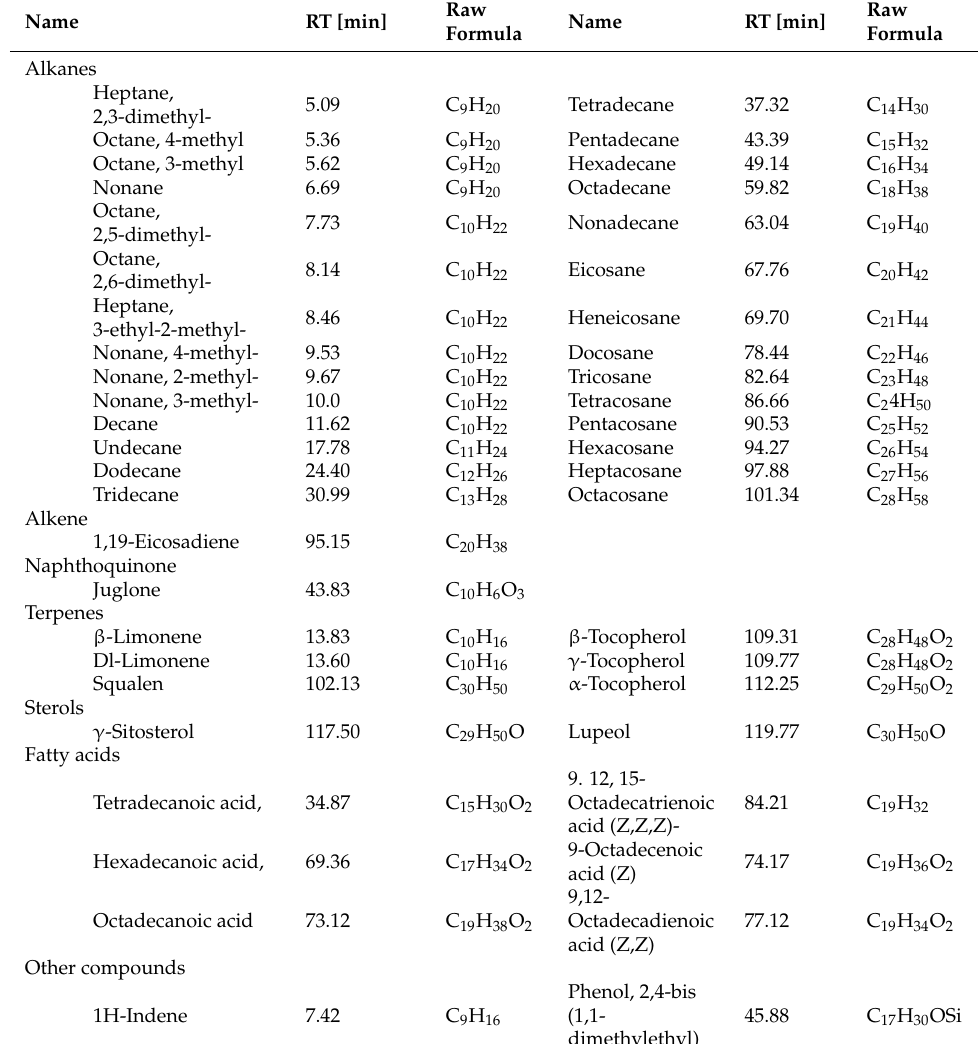
Table 1. Chemical compounds identified in non-polar extracts of various varieties of walnut husk by gas chromatography-mass spectrometry